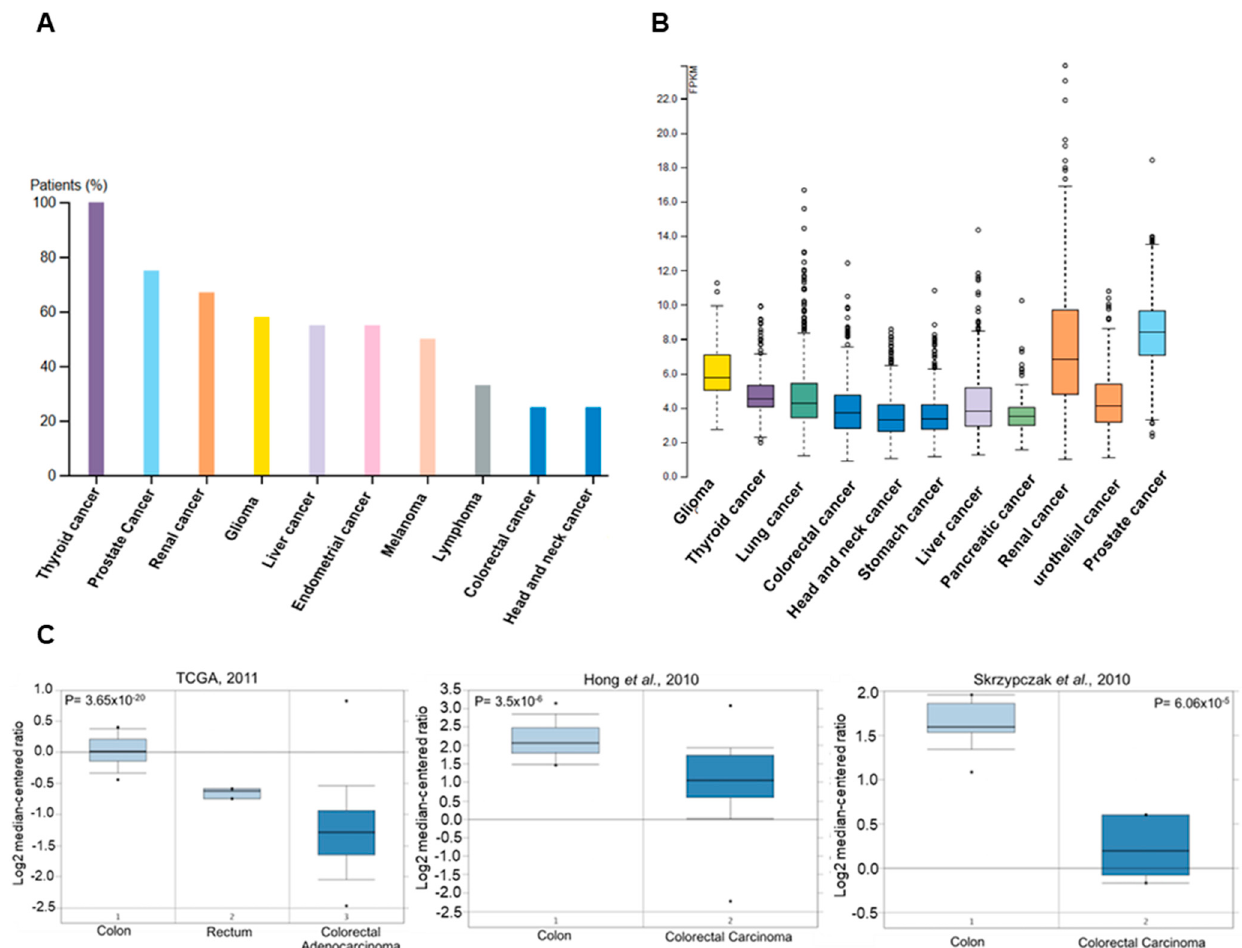
Figure 1. PMI levels are attenuated in CRC tissues. ( A ) PMI levels in the cytosol were assessed using anti-PMI antibodies in patients with different types of tumors. ( B ) RNA-seq analysis for PMI was performed on different types of tumors. Data were obtained from ATLAS protein expression (data extracted on Nov 2019). ( C ) Expression levels of PMI mRNA [19,20].